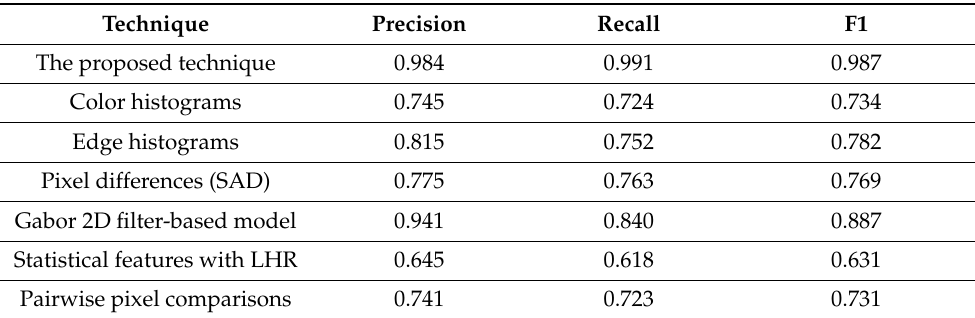
Table 1. Video segmentation method comparison